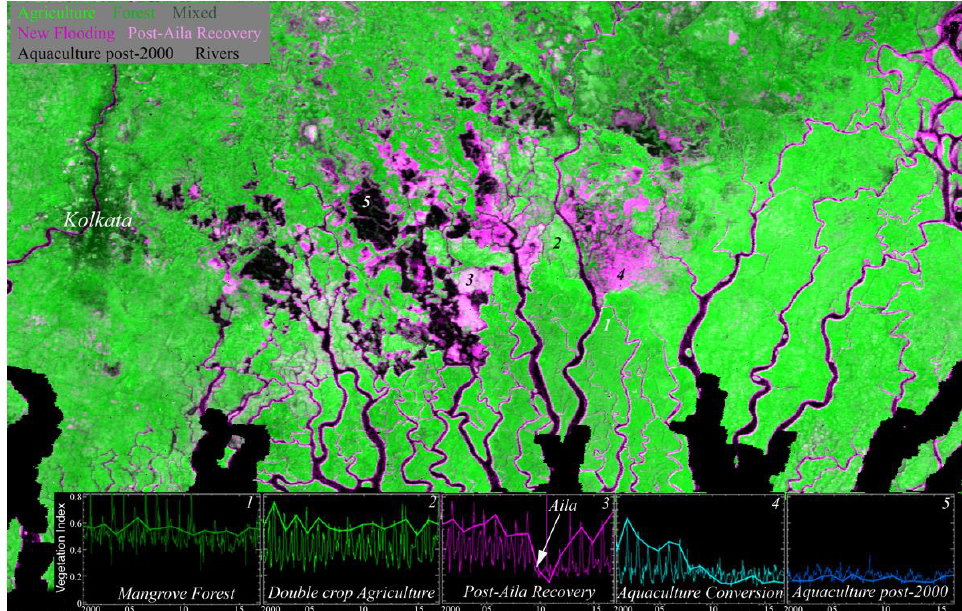
Figure 5. Changes in post-monsoon land cover on the lower GBD 1999 – 2016, as imaged by MODIS. Image shown is a false color composite in which the green channel represents the temporal average (mean) and the red and blue channels both represent the variability (standard deviation) of MODIS EVI for JD 314 in each year, showing overall abundance and variability in vegetative cover. Areas with persistently low EVI (black) or with highly variable EVI (magenta) indicate presence of aquaculture and/or flooding. A number of areas were visibly impacted after Cyclone Aila in 2009. Administrative boundaries of Bangladeshi polders are shown in white. International Bangladesh/India border shown in yellow. All EVI time series plots are scaled from 0 to 0.8.